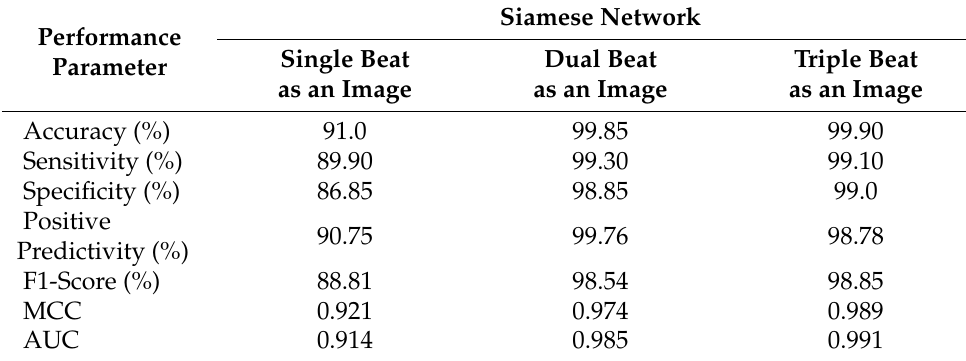
Table 9. Performance parameters of the Siamese